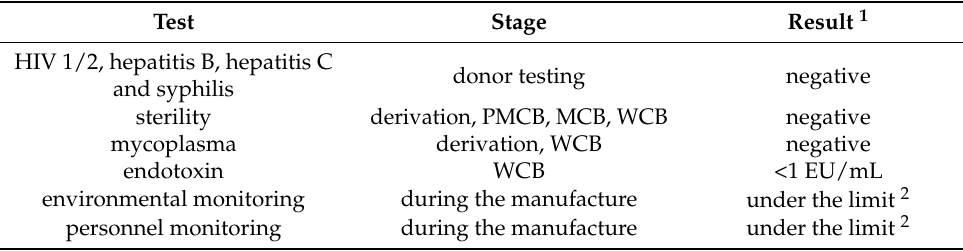
Table 5. Overview of the sterility tests for the hESC lines MUCG01, MUCG02, and MUCG03. PMCB, pre-master cell bank; MCB, master cell bank; WCB, working cell bank. Test Stage Result 1 HIV 1/2, hepatitis B, hepatitis C donor testing negative and syphilis sterility derivation, PMCB, MCB, WCB negative mycoplasma derivation, WCB negative endotoxin WCB <1 EU/mL environmental monitoring during the manufacture under the limit 2 personnel monitoring during the manufacture under the limit 2